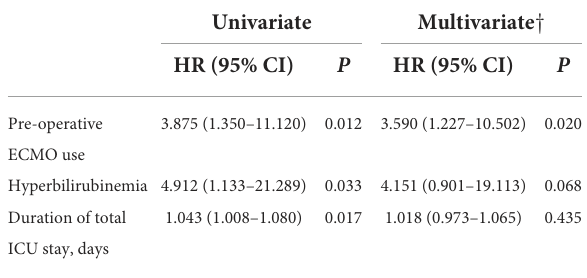
TABLE 4 Risk factors for asymmetric leg weakness after lung transplantation.